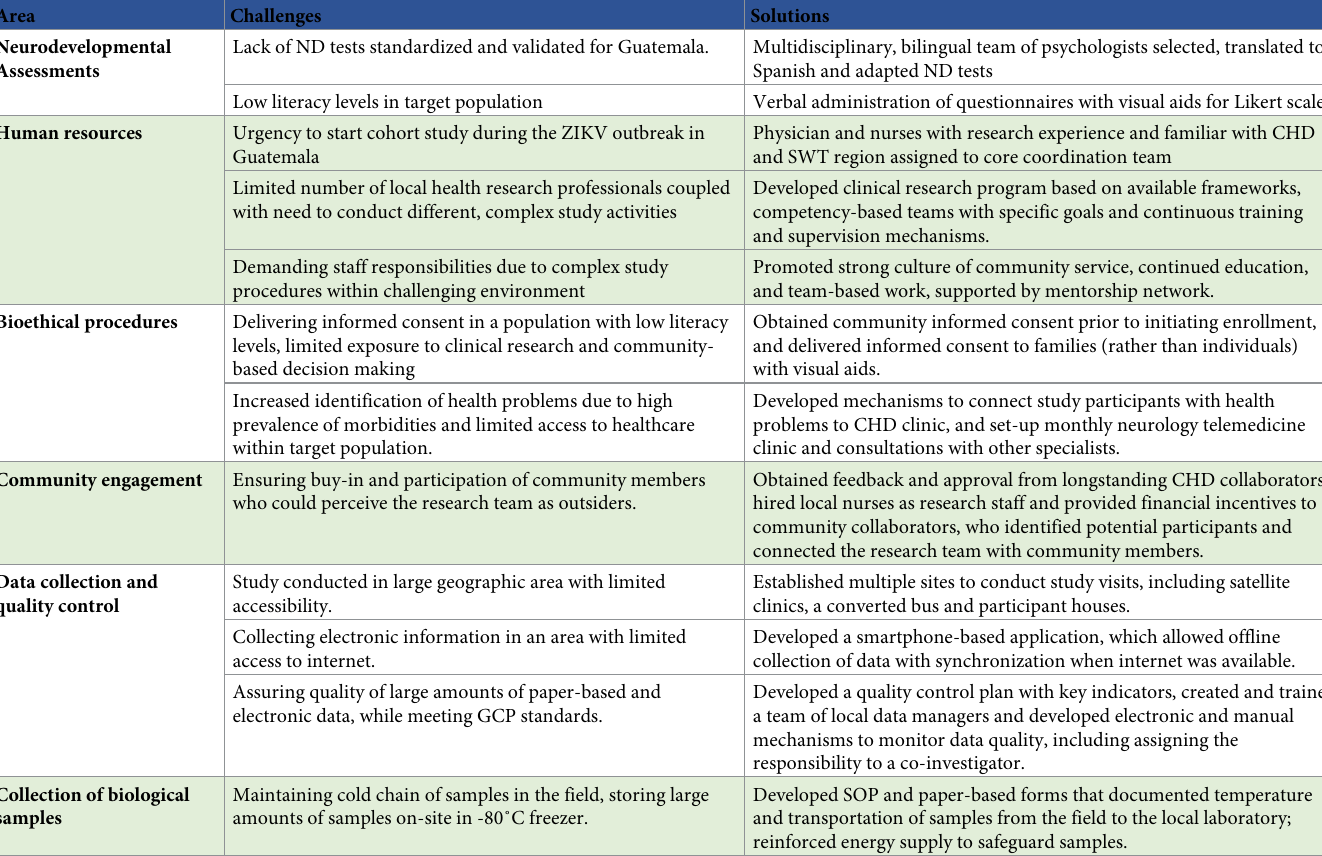
Table 2. Challenges of operationalizing the study protocol and implemented solutions.